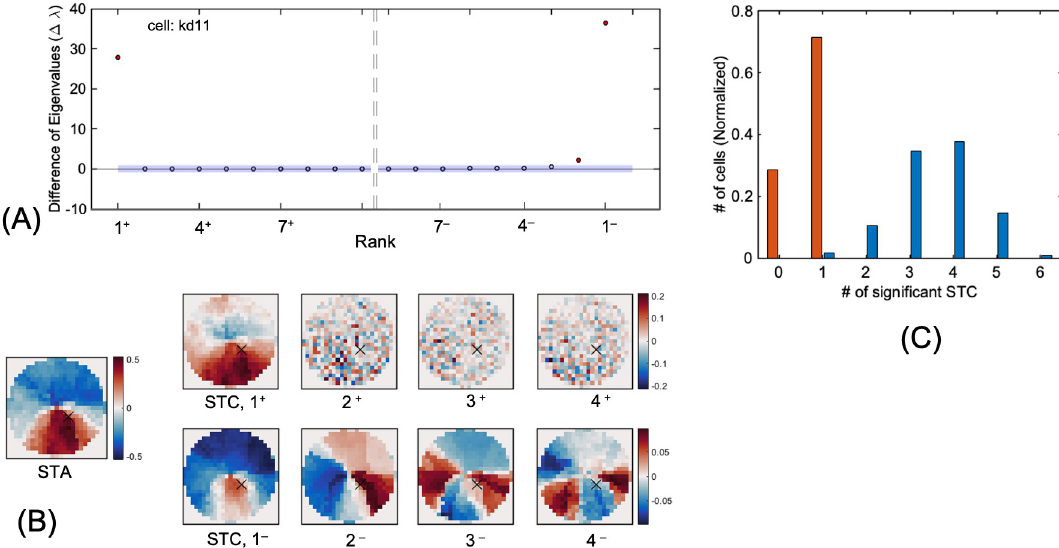
Fig 7. Computation of RF-FG STC s. (A) Difference of eigenvalue in the rank order of eigenvalues for an example neuron. Rank of +1 and –1 represent those with the largest (positive) and smallest (negative) eigenvalues, respectively. The largest 10 and smallest 9 eigenvalues were shown here. Blue error shade indicates ± 1 SD of the difference in eigenvalues estimated from randomization. Red dots indicate significance. Three RF-FG STC s were considered significant (1 + , 1 − , and 2 − ). (B) RF-FG STA and RF-FG STC s estimated for an example neuron. The top row indicates RF-FG STC s with the numbers corresponding to the rank in ascending order from the positive (1 + , 2 + , 3 + , and 4 + ). The bottom row indicates RF-FG STC s with the numbers in descending order from the negative (1 − , 2 − , 3 − , and 4 − ). Reddish and blueish colors indicate the polarity of the RF-FG STC . The same conventions were used as in Fig 2. The significant RF-FG STC s (1 + , 1 − , and 2 − ) show a clear dichotomy between figure and ground while nonsignificant RF-FG STC s show multiple regions (3 − and 4 − ) and mosaic-like distributions (2 + , 3 + , and 4 + ). (C) Distribution of the number of significant RF-FG STC s for single neurons. Red and blue bars indicate the RF-FG STC counted from the largest (positive) and smallest (negative) eigenvalues, respectively. A number of neurons had a few significant RF-FG STC s with the median of three.